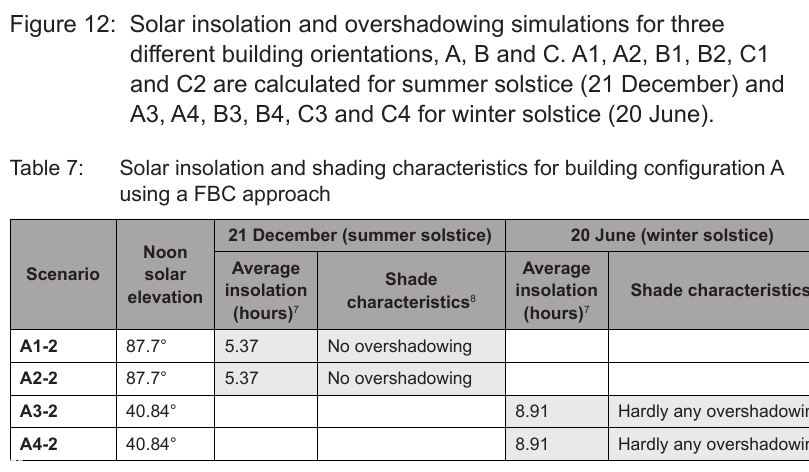
Average insolation hours for only building 2. Shading characteristics for buildings 1, 2 and